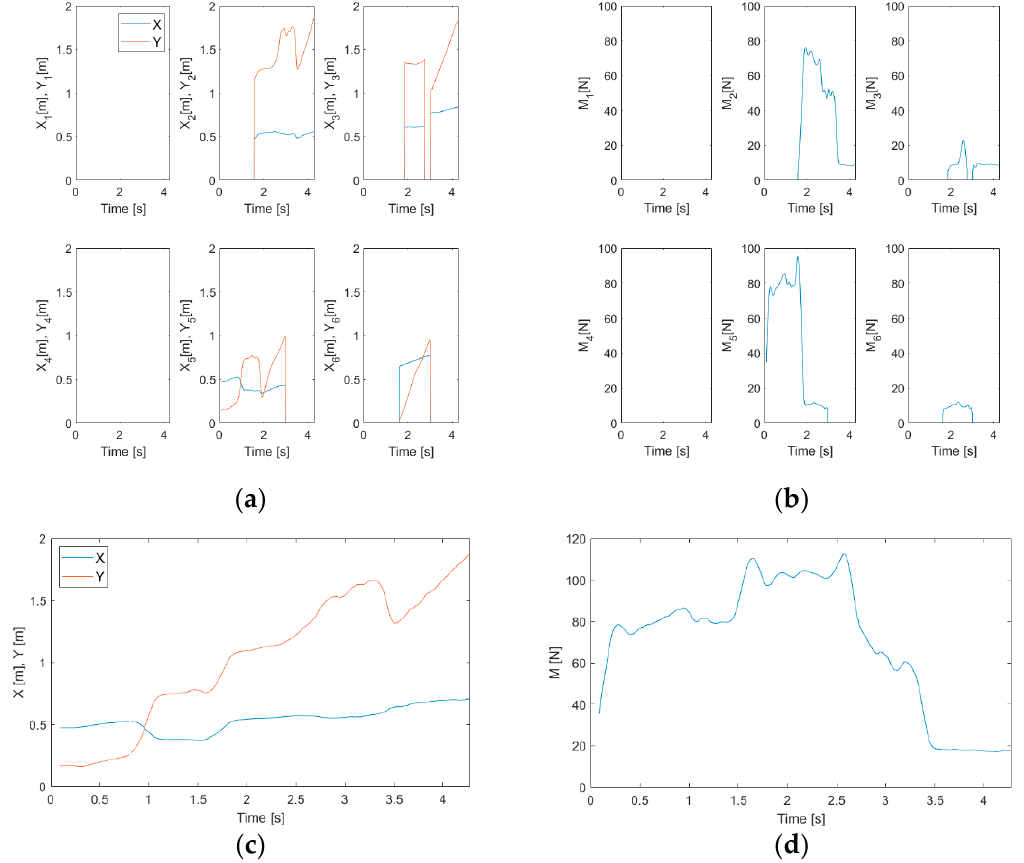
Figure 7. Trajectories and applied forces with respect to time: case of a person pulling a luggage on wheels. ( a ) X and Y coordinates for each footboard; ( b ) vertical force resultant magnitude for each footboard; ( c ) total X and Y coordinates; ( d ) total vertical force resultant